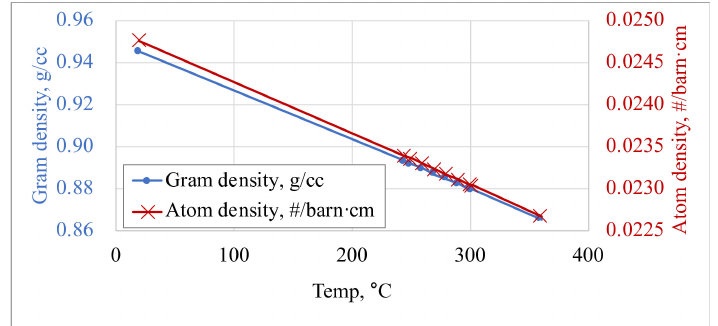
Figure 12. Sodium density as function of temperature.